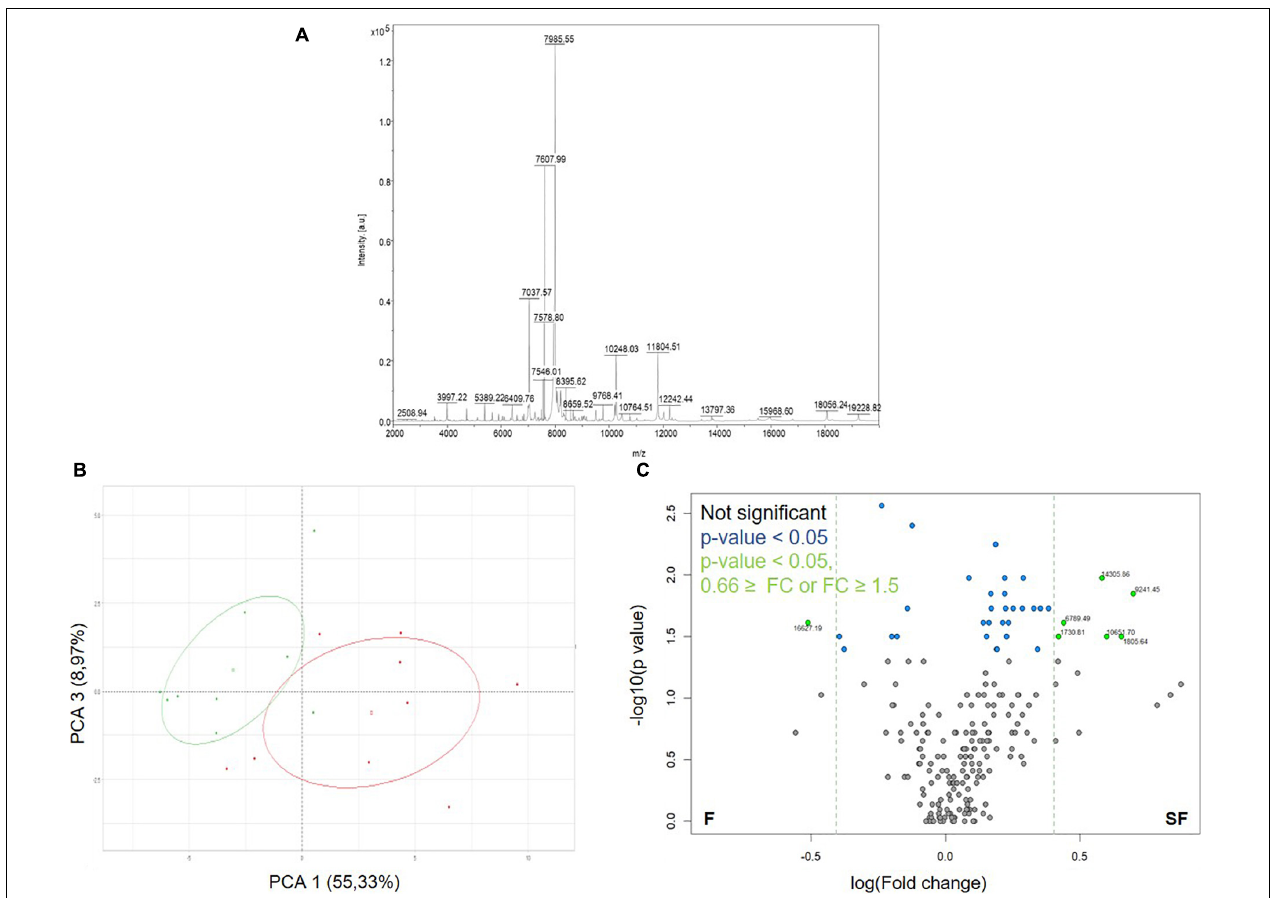
FIGURE 2 | Protein content exploration of sperm from fertile (F) and subfertile (SF) meat-line roosters by ICM-MS. (A) Representative sperm cell ICM-MS spectra from one F animal. (B) Principal component analysis (PCA) of ICM-MS signals obtained for F (in green) and SF (in red) roosters. (C) Volcano plot analysis between F and SF animals of detected m/z peaks ( n = 211). Gray points indicate not significant peaks, blue ones, peaks with a significant abundance difference between F and SF animals ( p < 0.05), and green ones, the significant peaks presenting a fold change (FC) ≤ 0.66 or ≥ 1.5.